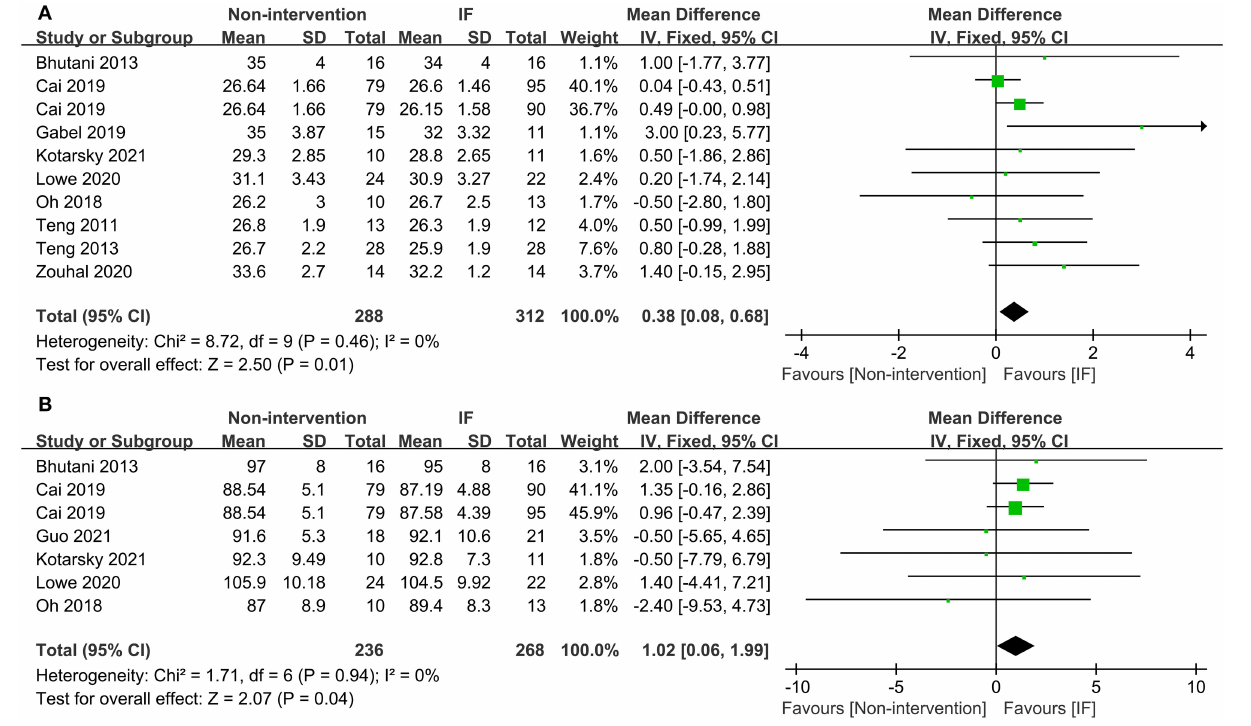
weekly TRF reduced WC more effectively than CR (WMD = 3.36, 95% CI: 1.24–6.08, p = 0.003; I 2 = 38%) ( Table 3 ).